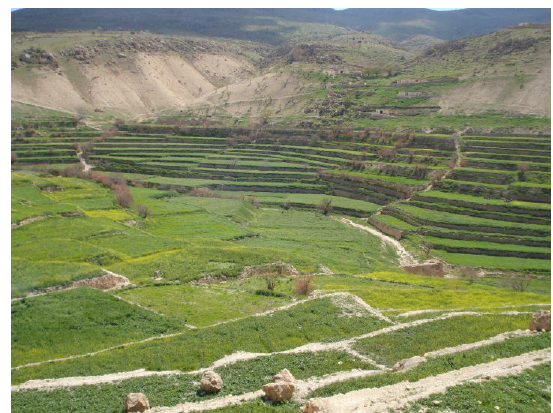
Figure 2. Farm in Sinjar